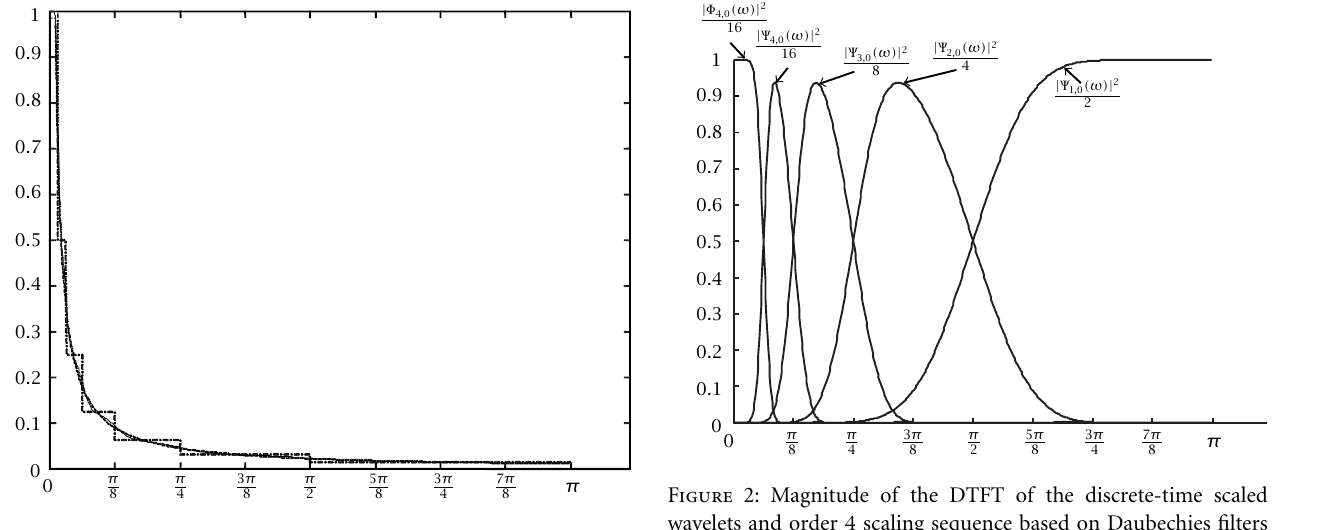
Figure 1: 1 /f -like noise: synthesized by means of Daubechies wavelet(solidline),synthesizedbyidealsbandpasswavelets(dashed- dotted line) and ideal 1 /f behaviour (dashed-line).